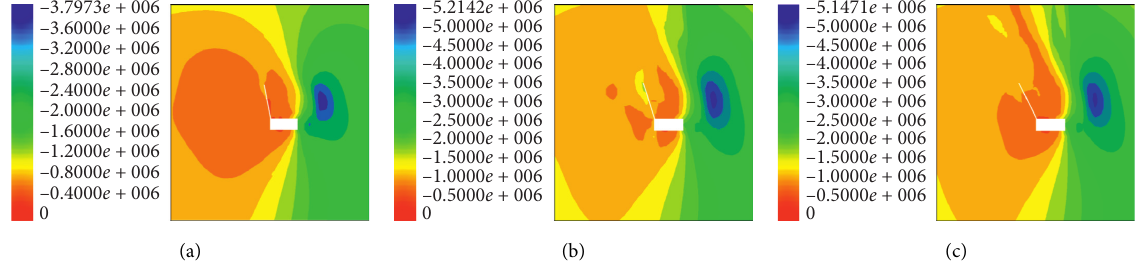
Figure 11: Vertical stress diagram of different roof cutting angles. (a) 10 ° . (b) 20 ° . (c) 25 ° .